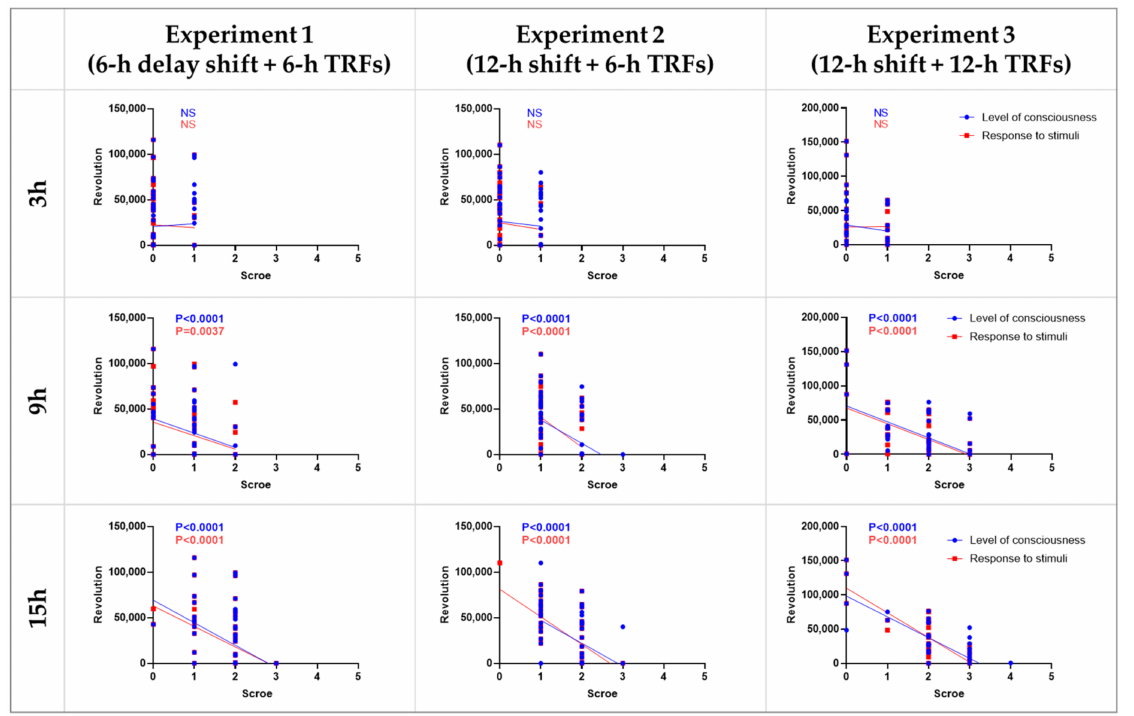
Figure 8. Correlation between septic scores and wheel revolutions. The X-axis in each graph represents the scores of the level of consciousness (blue) and response to stimuli (red) at 3, 9, and 15 h after LPS injection. The Y-axis represents the total number of wheel revolutions 7 days following LPS injection. NS, no statistical difference, Spearman correlation